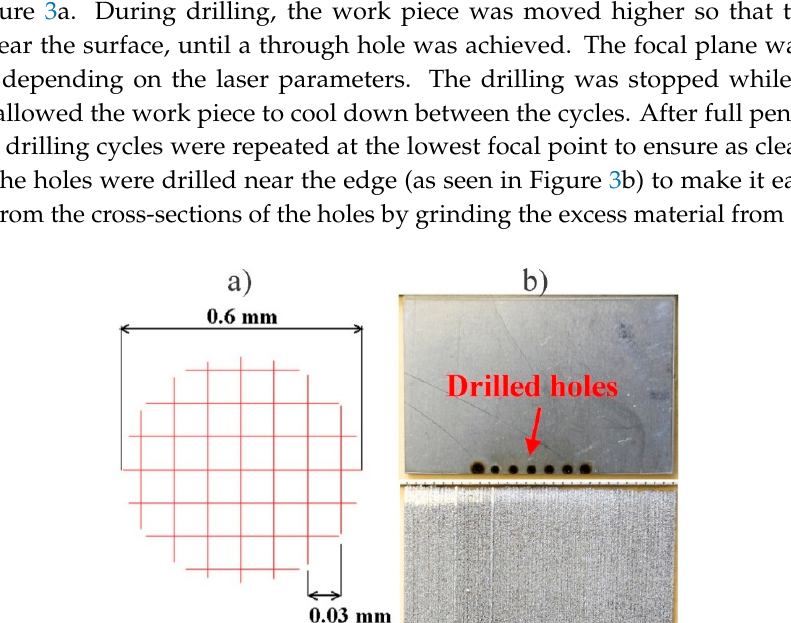
Figure 3. ( a ) Hatch pattern illustration for the engraving, not in scale. Red lines denote laser beam movement. ( b ) Photographs of the drilled sheets, drilled holes were 2 mm apart. Cold rolled sheet on top, PBF sheet on bottom.